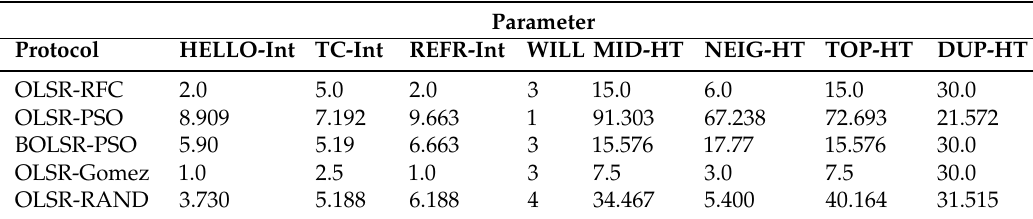
Table 2. Configuration Parameters of Each